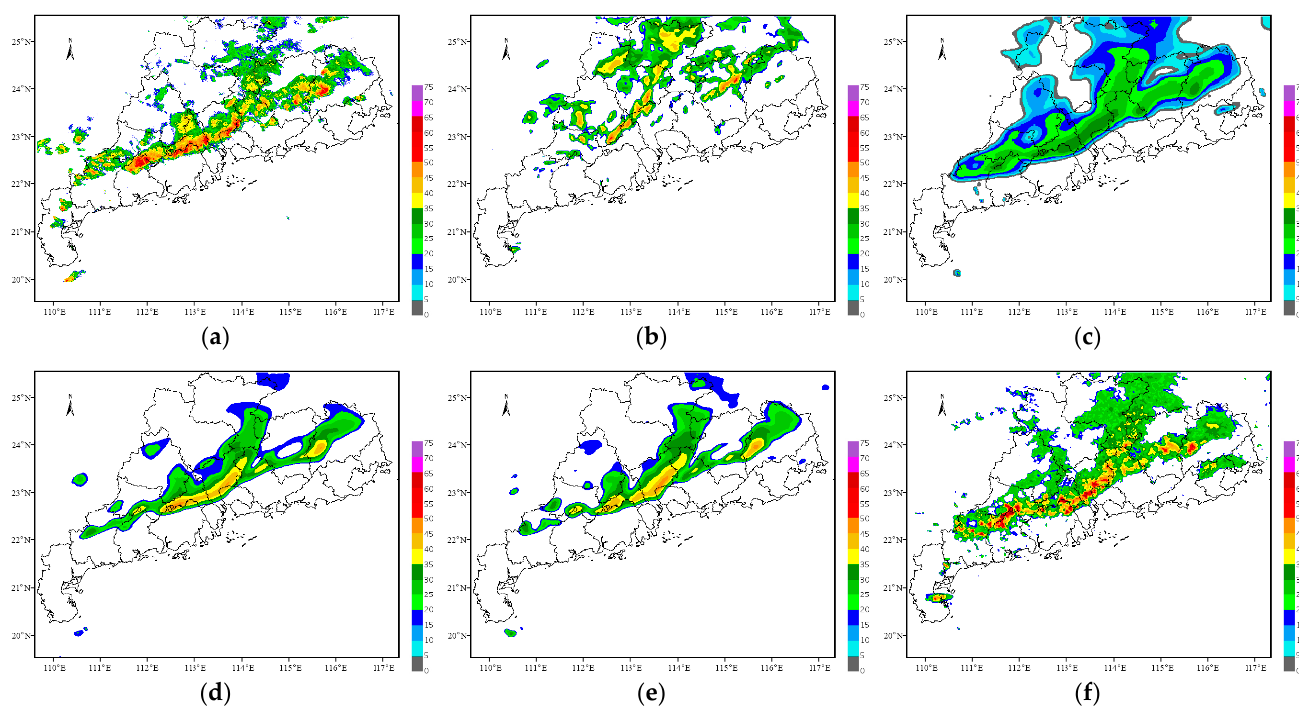
Figure 6. Nowcasting results of the squall line process for the next 1.5 h. ( a ) Observation; ( b ) Opti- calflow; ( c ) ConvGRU; ( d ) PredRNN; ( e ) PredRNN V2; ( f ) TSGAN.